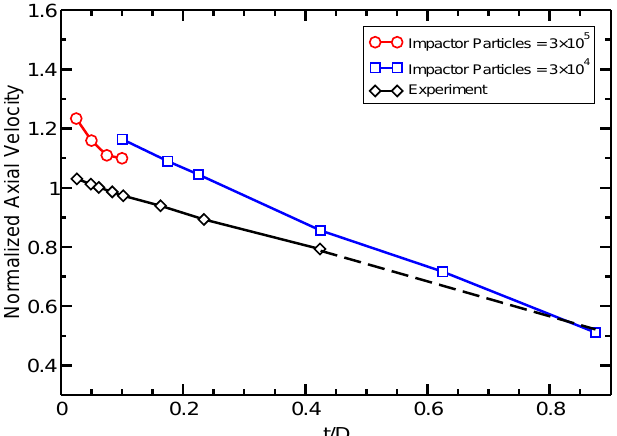
Figure 13. Debris cloud axial expansion velocity with v 0 = 6.7 kms − 1 at different t/D ratios. The simulation results are compared to experiments by Piekutowski [50]. The dotted line represents linearly extrapolated experimental